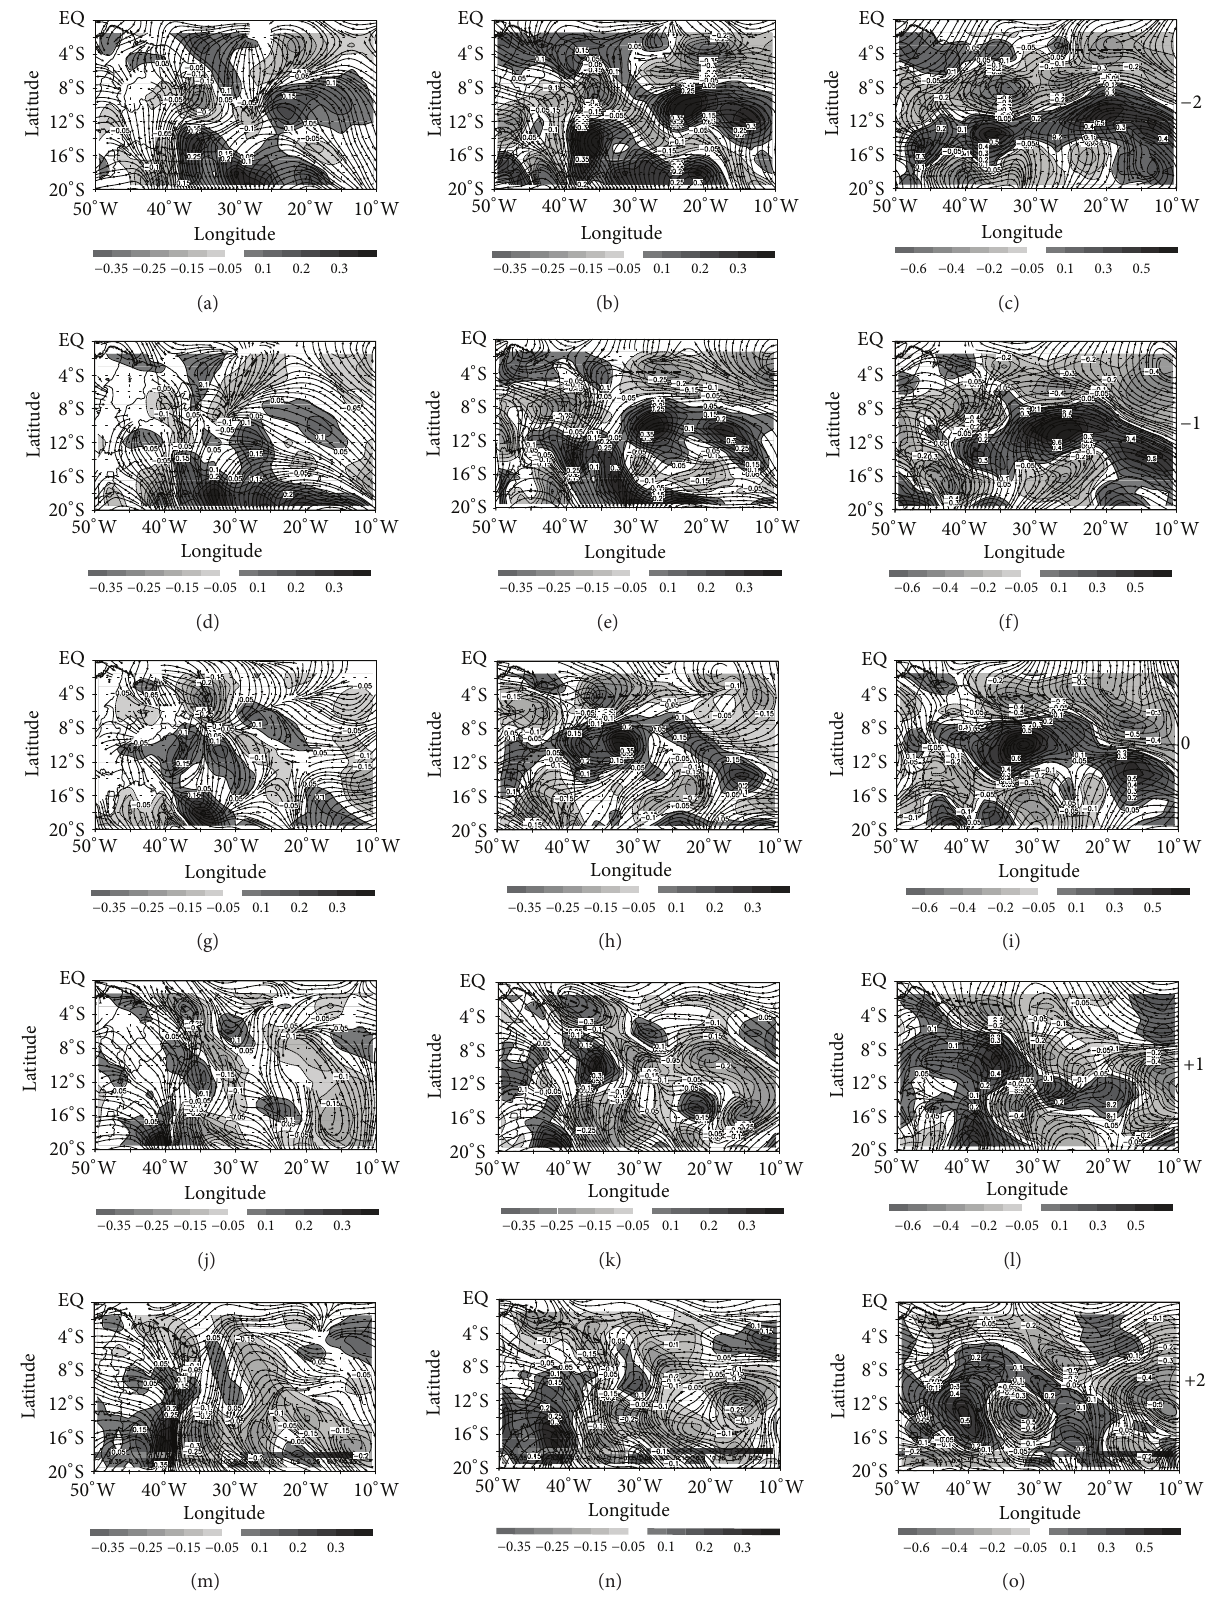
Figure 6: Relative vorticity (shaded, 10 −5 s −1 ) and streamlines composite anomalies in the period from April to July 2007 at 1000 hPa (left column), 850 hPa (center column), and 700 hPa (right column). The approximate trough axis is shown by dashed